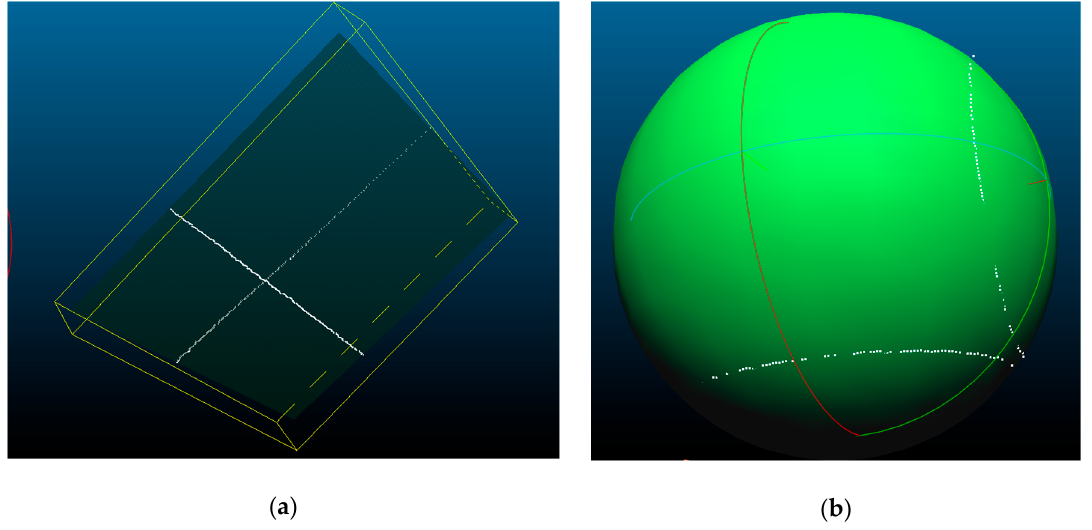
Figure 12. Validation of the point cloud. ( a ) The green part is the wall with the accuracy 1.2 mm measured by terrestrial laser scanning (TLS), and the plane fitting error of our calibrated system is 8.085 mm. ( b ) The green part is the sphere with the radius of 0.325 m and the accuracy of 3 mm measured by TLS, and the spherical radius and the spherical fitting error of our calibrated system are 0.326 m and 3